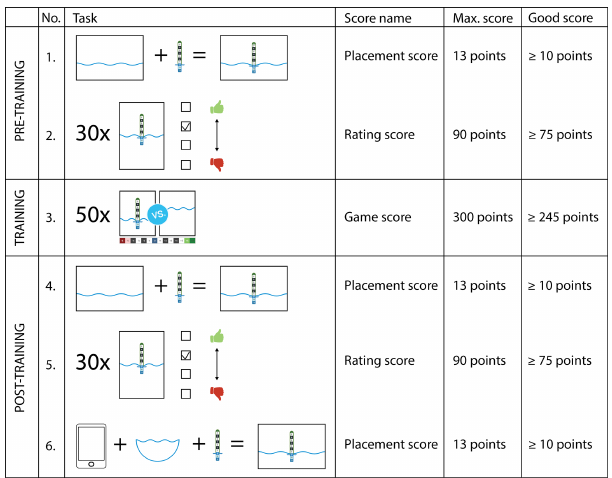
Figure 2. Schematic overview of the pre-training, training and post- training tasks. For each task, the maximum number of points and the chosen value for good performance are